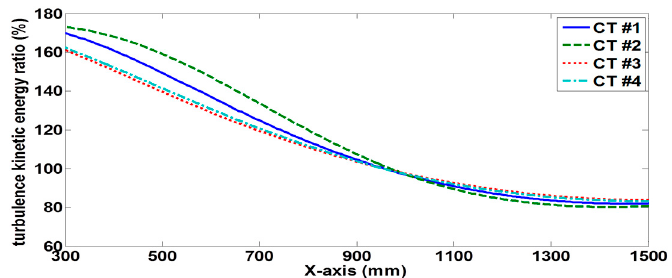
Figure 8. Turbulence kinetic energy ratio change along the wind tunnel wall.